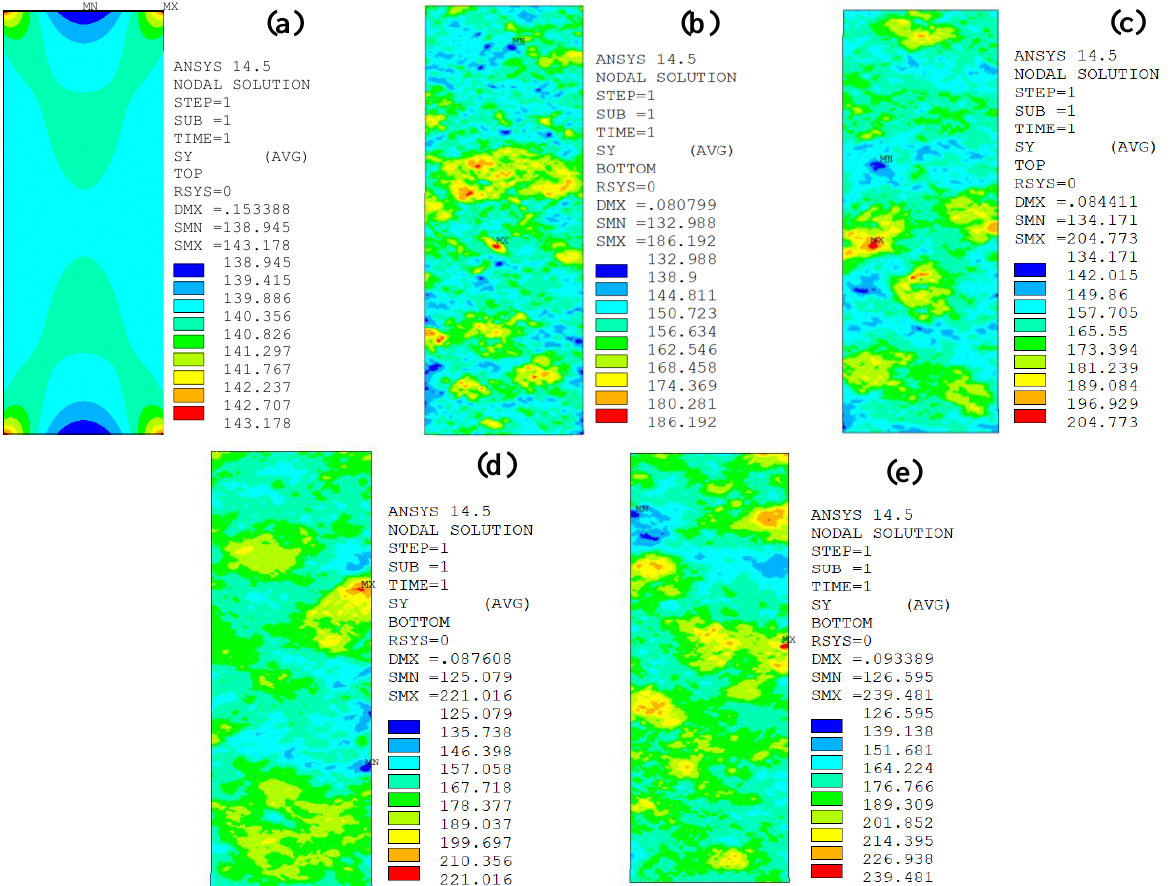
Figure 13. Peak tensile stress distribution on the unpatched corroded steel surfaces with various corrosion durations: ( a ) C0-1, ( b ) C6-1, ( c ) C9-1, ( d ) C15-1, ( e ) C18-1.